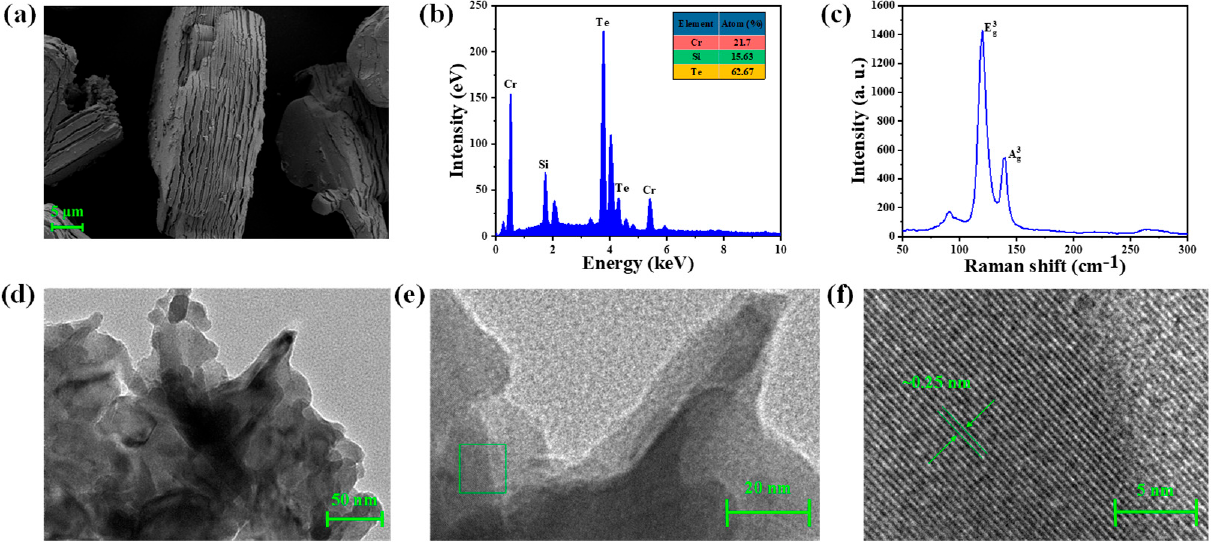
Figure 2 . Characteristics of the Cr 2 Si 2 Te 6 nanosheets. ( a ) SEM image, ( b ) EDS spectrum, ( c ) Raman spectrum, ( d - f ) HRTEM images at different resolutions.